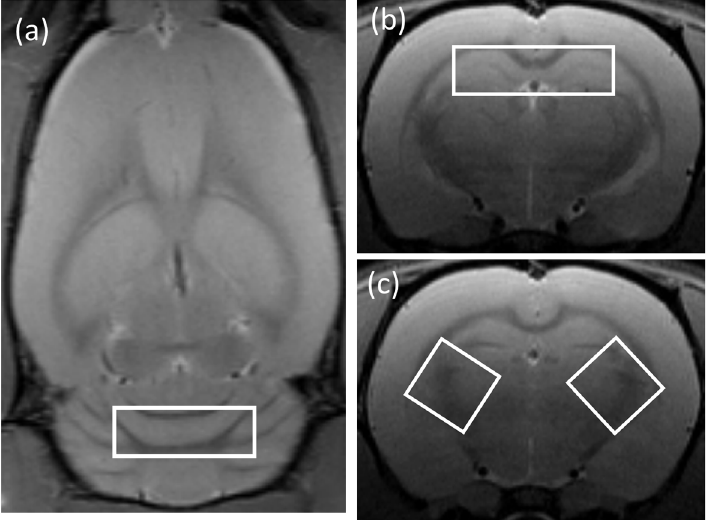
Fig 1. Placement of the MRS voxels (white contours) on (a) cerebellum, (b) hippocampus, and (c) bi- lateral internal capsule on representative MR images of a